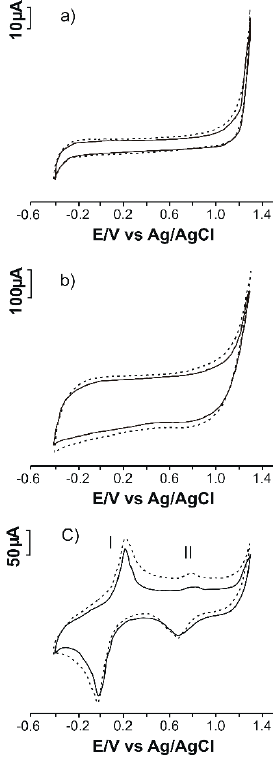
Figure 3. Cyclic voltammograms of the ( a ) CoPc-SPCE; ( b ) MB-SPCE; ( c ) PB-SPCE immersed in 10 − 1 M KCl solution (dashed line) and 10 − 3 M Phe–10 − 1 M KCl solution (solid line) registered at 0.6 V × s −